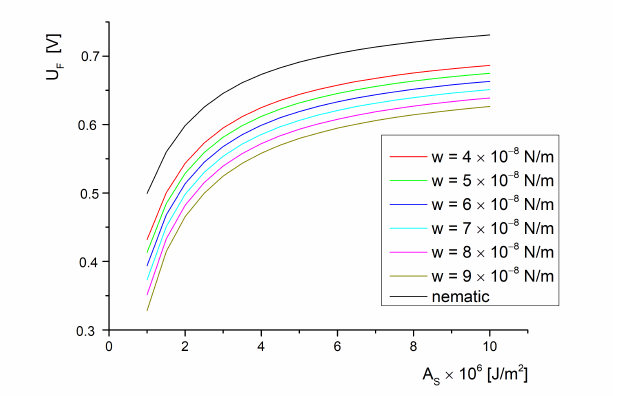
Figure 2. Freedericksz transition threshold versus anchoring strength energy for different interac- tion